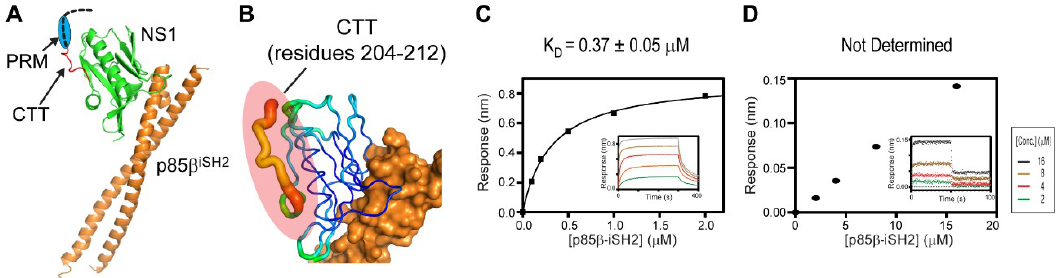
Figure 4. Ternary interaction between 1918 NS1, p85  , and CRK. ( A ) Schematic showing the NS1- bridged (left) and p85  -bridged (right) ternary complex. BLI-derived binding isotherms between the 1918 NS1 ED-CTT :p85  complex and ( B ) CRK-II and ( C ) CRK-L. Insets: representative BLI sensorgrams with different analyte concentrations are shown by different colors. K D values and uncertainties are the global fitting result of three repeated data.